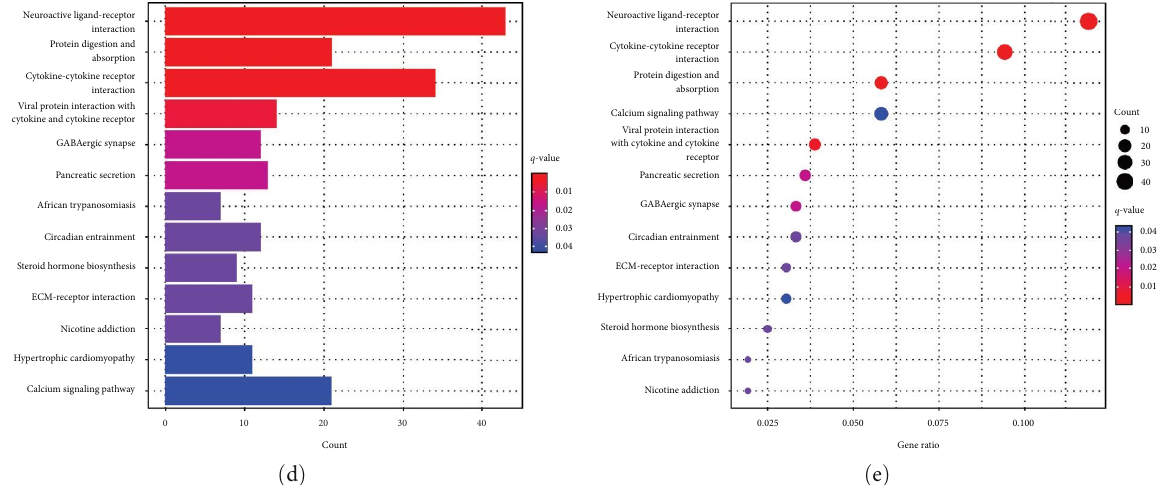
F IGURE 6: GO/KEGG enrichment analysis of DEGs between high- and low-NUDT1 expression: (a – c) GO enrichment analysis; (d, e) KEGG enrichment analysis.